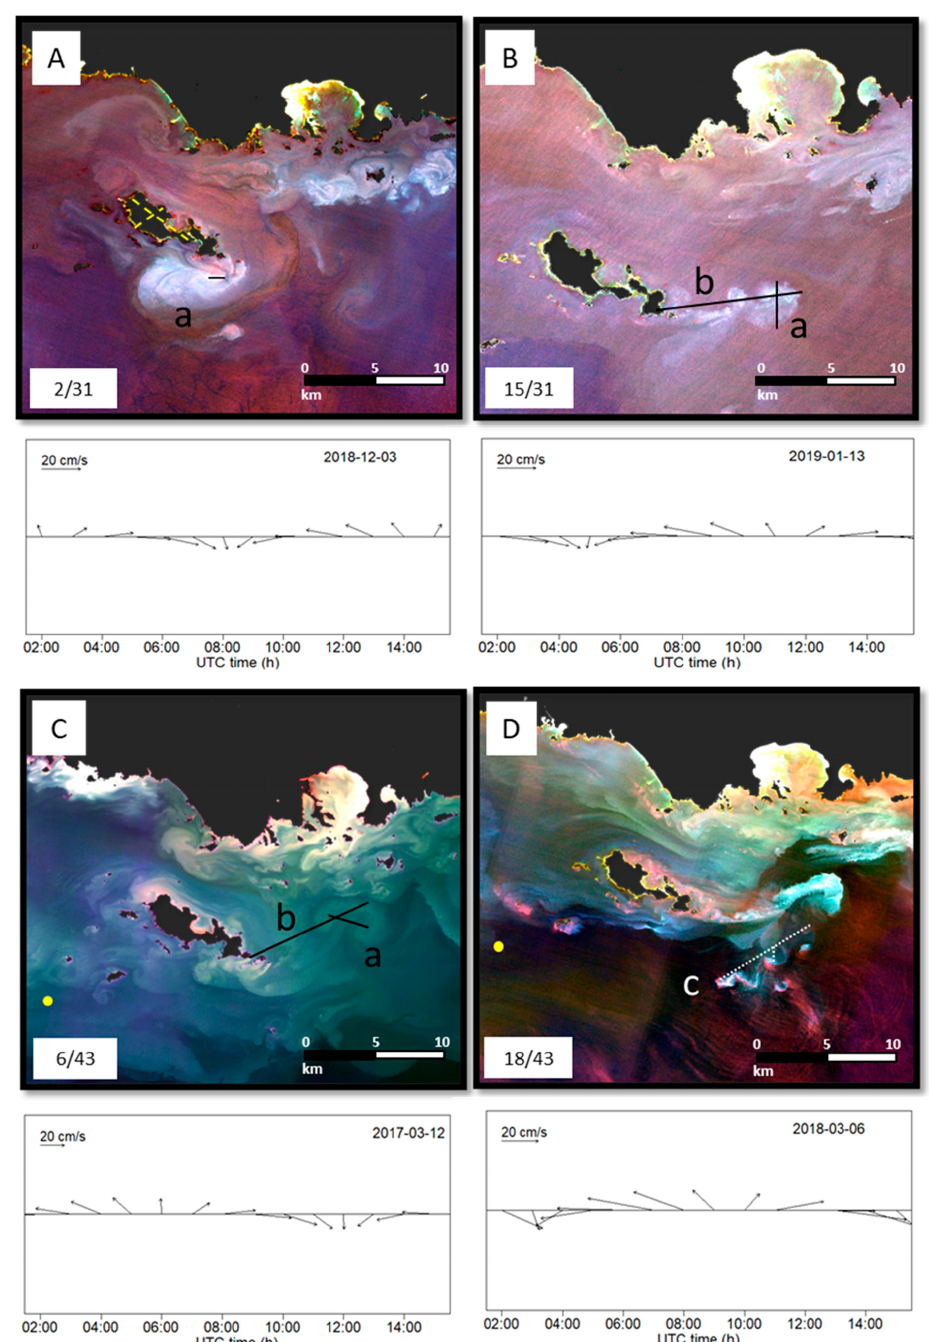
Figure 6. Structures associated with Tova and Tovita islands. ( A ) Cyclonic eddy south of Tovita Is., after 4 h of WNW tidal current. ( B ) Associated eddies chain northeast of Tovita Is., after 6 h of N. tidal current. ( C ) Eddies south and dipole with a jet to the northeast of Tovita Is., after 5 h of S. tidal current. ( D ) Eddy south of Tova and Tovita Is., dipole with a jet to the northeast and chain of eddies to the southeast, after 1 h of ESE tidal current. Black/white lines indicate how the structures were measured, being (a) width of eddies, dipole, or eddies chain, (b) distance from Tovita Is. and (c) length of associated eddies chain. Numbers in the lower left corner represent the number of scenes showing this particular structure (linked with Table 4). The arrow time series below each image represents the tidal current velocities 12 h prior to the acquisition of the image as extracted from TPXO data at the locations marked by yellow points on the corresponding